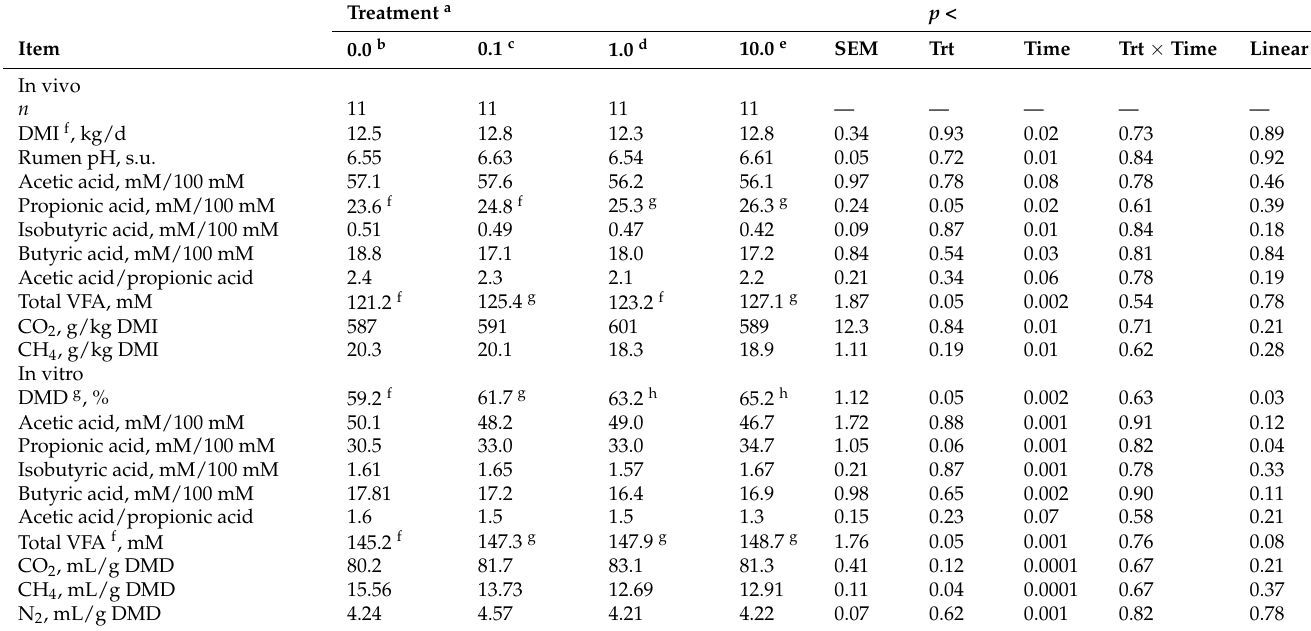
Table 2. Influence of direct fed microbial dose on in vivo and in vitro fermentation characteristics. Treatment a p